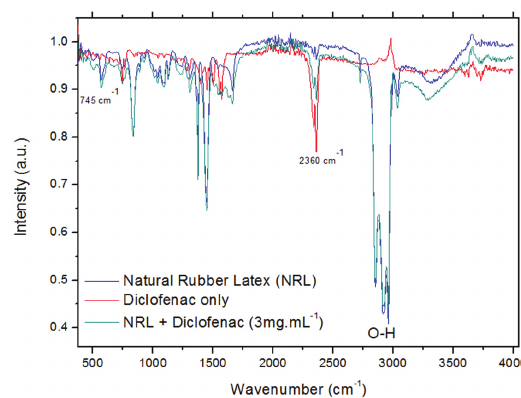
Figure 7. FTIR spectra after of incorporation of sodium diclofenaci in natural rubber